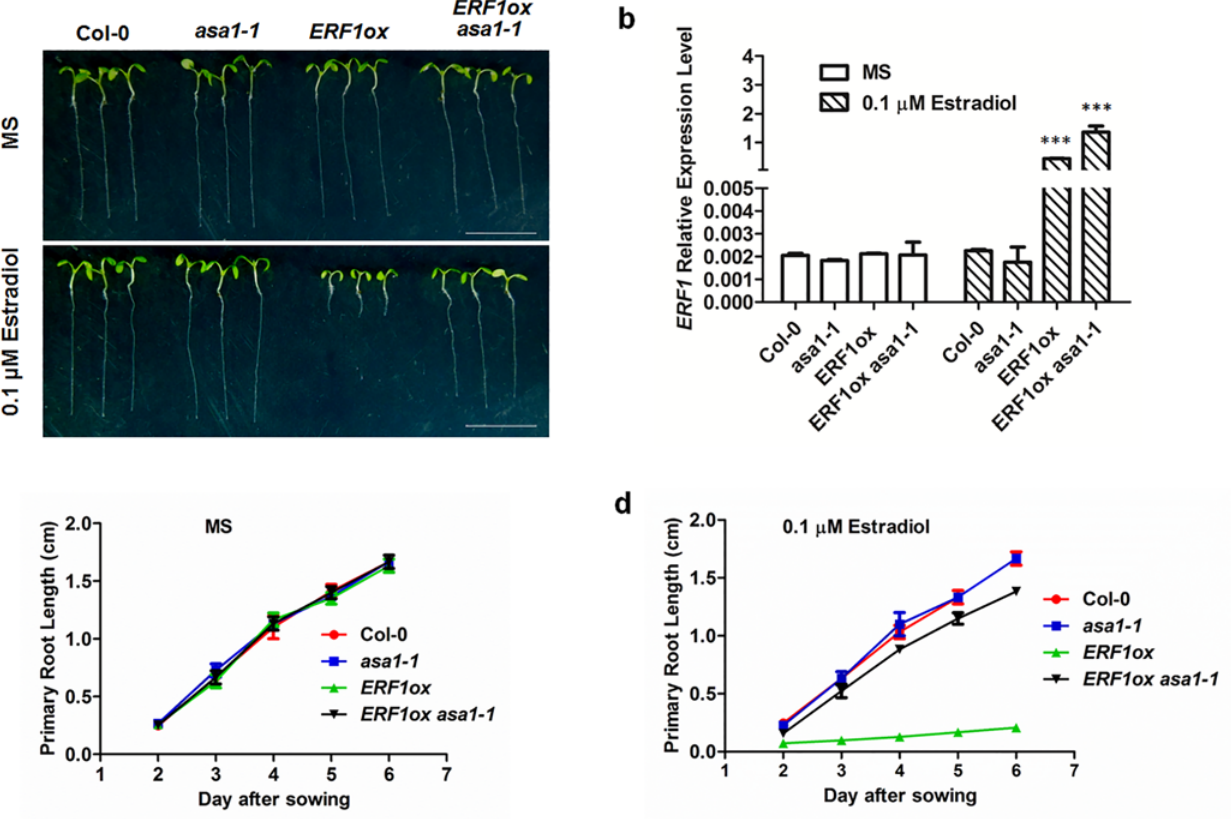
Fig 8. ASA1 acts downstream of ERF1. ( a ) The primary root phenotypes of Col-0, asa1-1 , ERF1ox and ERF1ox asa1-1 seedlings grown on MS medium with either 0 or 0.1 μ M estradiol for 5 d. ERF1ox is the transgenic plants expressing ERF1 protein under control of the estradiol-inducible promoter in Col-0 background. Scale bar, 1 cm. ( b ) qRT – PCR analysis of transcriptions of ERF1 . The roots of 5-day-old Col-0, asa1-1 , ERF1ox and ERF1ox asa1-1 seedlings grown on MS medium with either 0 or 0.1 μ M estradiol were used. Values are mean ± SD of three replicas ( *** P < 0.001. Asterisks indicate Student ’ s t-test significant differences). ( c-d ) Primary root length of Col-0, asa1-1 , ERF1ox and ERF1ox asa1-1 seedlings grown on MS medium with either 0 or 0.1 μ M estradiol were measured at the fifth days. Data shown are average and SD (Values are mean ± SD, n =